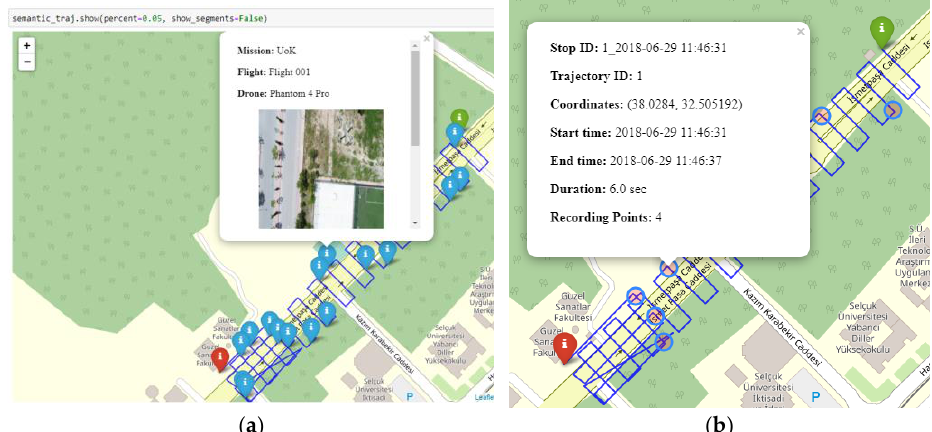
Figure 13. Visualization of a segmented trajectory.